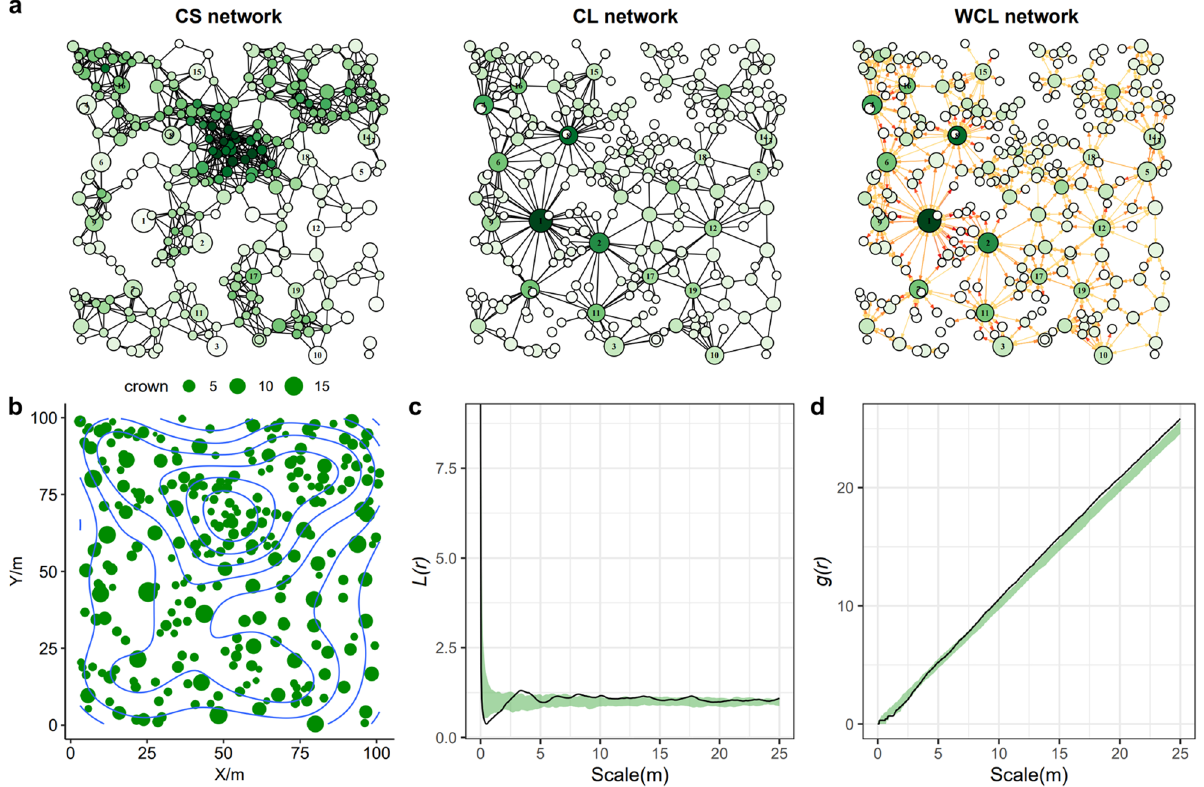
Figure 6. ( a ) Three types of networks ( CS competition for space, CL competition for light, WCL weighted competition for light) based on the forested swamp plot FS-1 in Costa Rica. Each node represents a tree, and each edge reflects competition. The size of the node reflects the radius of the tree crown. Deeper colors indicate a higher value of node degree. In WCL, the weight is proportional to the width and color depth of the edges. The nodes in the networks retain spatial coordinates in panel ( b ). ( b ) Distribution of trees in the plot. The size of the node reflects the radius of the tree crown. The blue contour indicates the density of trees. ( c , d ) Variations of univariate L ( r ) and g ( r ) functions based on the CSR model generated by 199 Monte-Carlo simulations. The boundary of envelopes reflects the maximum and minimum values of L ( r ) and g ( r ) functions in the simulations. The black line represents observed values estimated on the tropical rainforest